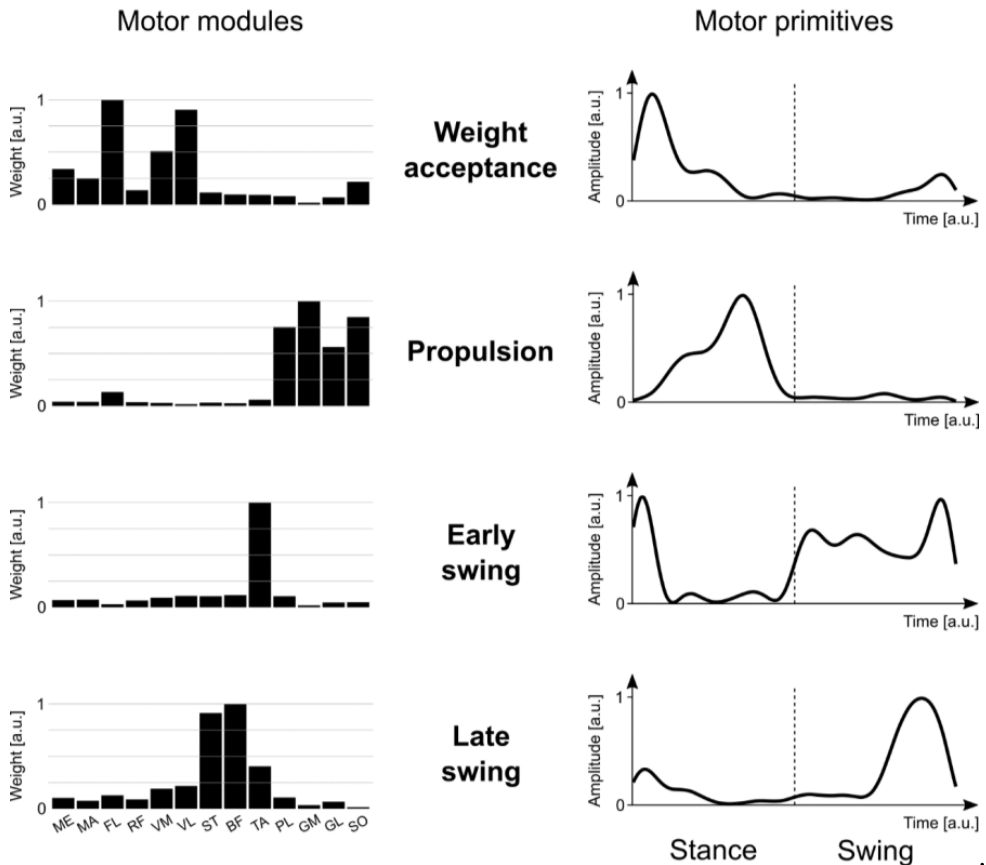
Figure 2. Muscle synergies for human walking. Exemplary motor modules and motor primitives of the four fundamental synergies for human walking extracted via nonnegative matrix factorization (NMF) on a unilateral muscle set. Motor modules are presented on a normalized y-axis base in arbitrary units. For motor primitives, the x-axis full scale represents the averaged gait cycle (with stance and swing normalized to the same amount of points and divided by a vertical dotted line), while the y axis represents the normalized amplitude in arbitrary units.